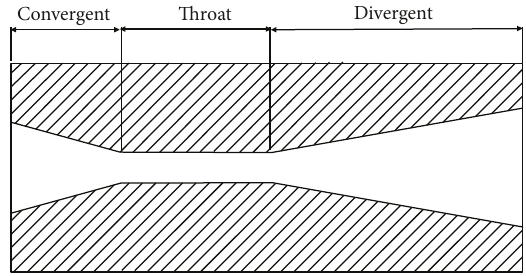
Figure 1: Structure of the Laval nozzle with a throat